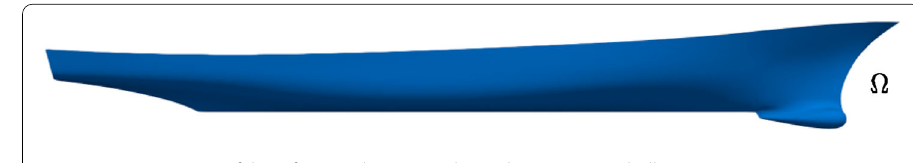
Fig. 2 Representation of the reference domain Ω , that is the DTMB 5415